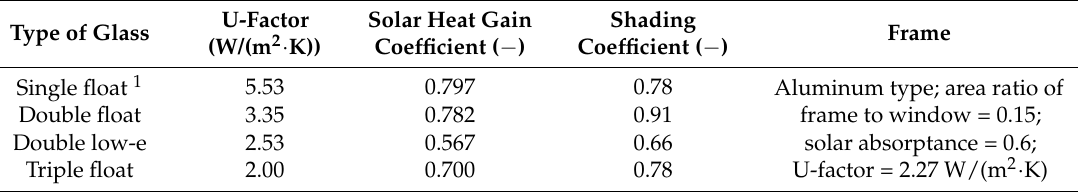
Table 13. Enhancement of the thermal insulation performance of glass.